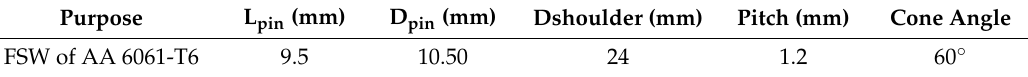
Table 3. Summary of dimensions of the tools used in Friction Stir Welding (FSW) experiments.